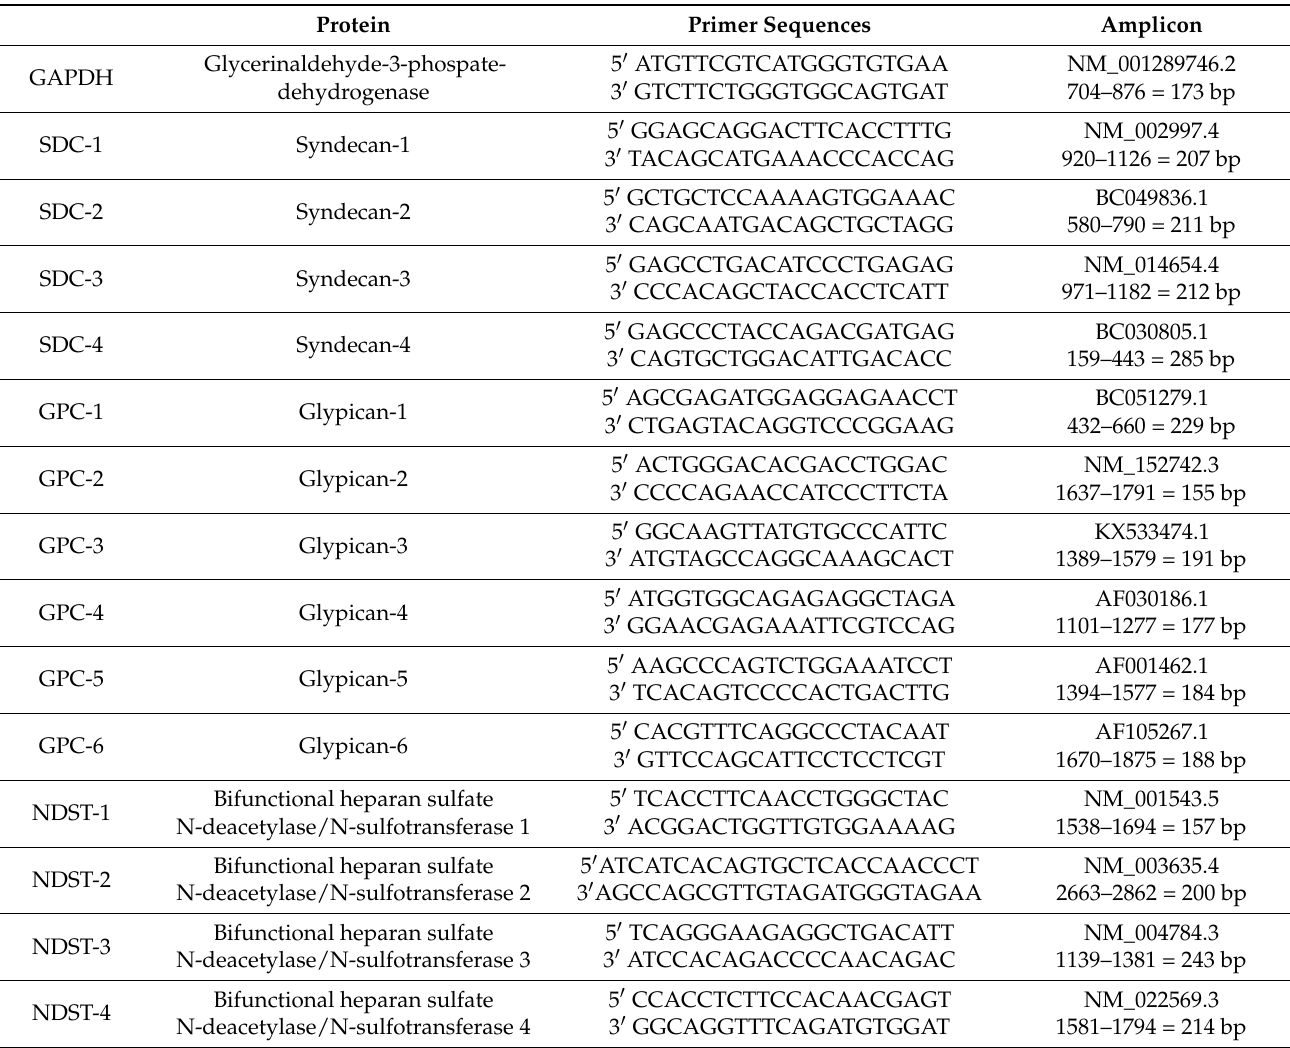
Table 4. Genes investigated by RT-qPCR and their respective primer sequences. Gene accession number used for primer design and position of the amplicon is depicted. Protein Primer Sequences